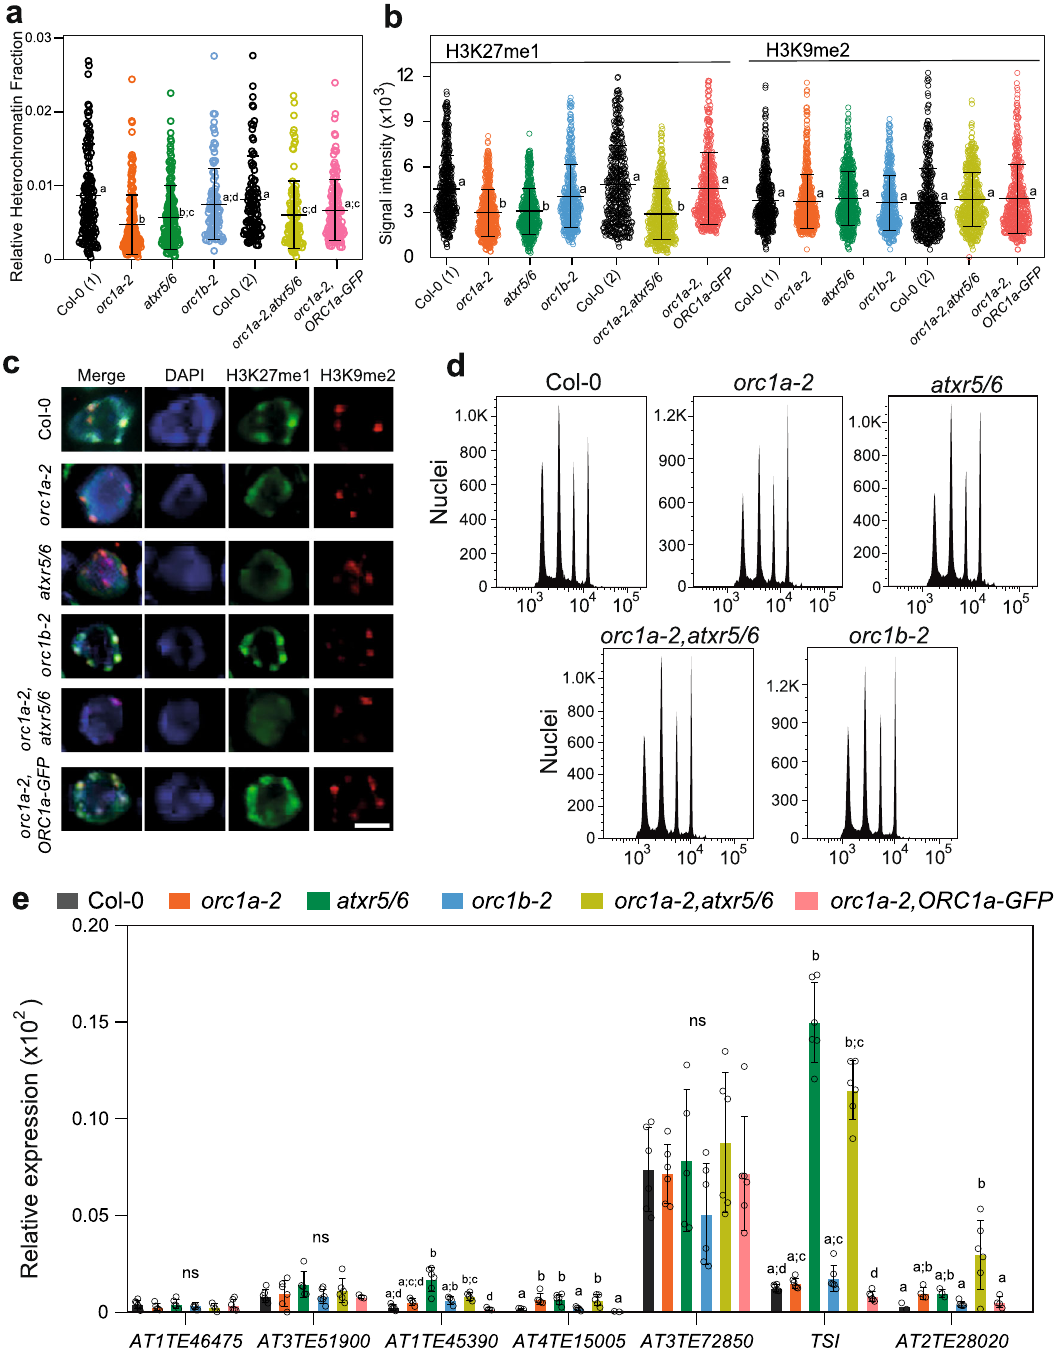
Fig. 5 | Role of ORC1a in the maintenance of H3K27me1 mark in hetero- chromatin. a Determination of the relative heterochromatin fraction (RHF) in nuclei of the indicated genotypes. Measurements were carried out in DAPI-stained nuclei ( n ≥ 100 nuclei of n ≥ 6 roots per genotype; the precise value of n for each genotype is provided in Supplementary Data 1). Data reported are the mean±s.d. Different letters near the average of each distribution indicate statistically sig- ni fi cant differences according to a one-way ANOVA analysis with the Tukey ’ s mul- tiple comparisons ( p <0.05). Exact p -values are detailed in Supplementary Data 1. b Distribution of H3K27me1 and H3K9me2 intensity signals detected in individual chromocenters of wild type (Col-0; two independent measurements), orc1a-2 , atxr5/6 , orc1b-2 , orc1a-2,atxr5/6 and orc1a-2,ORC1a-GFP nuclei. H3K27me1 and H3K9me2weredetected byimmuno fl uorescencein endoreplicatingroot cellsof7 day-oldseedlingsoftheindicatedgenotypes.Nucleiofepidermalcellswerescored in all cases (Supplementary Data 1). Data reported are the mean±s.d. Different